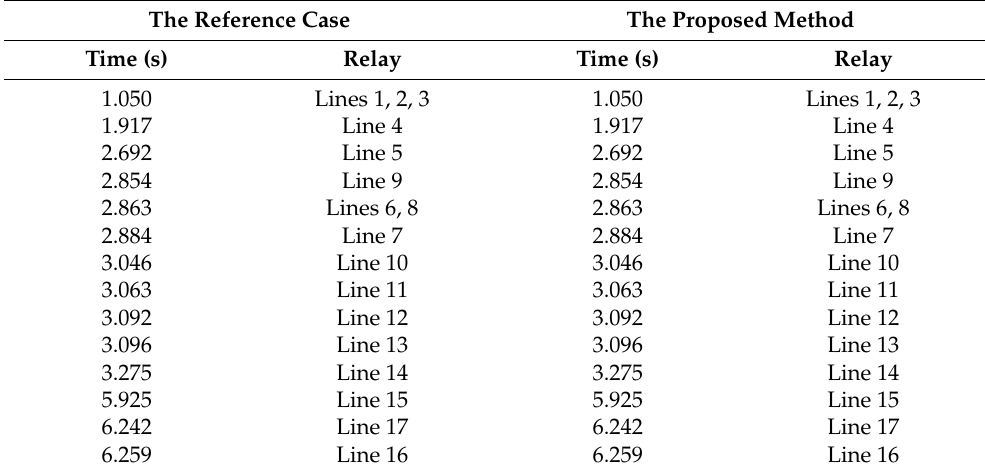
Table 6. The list of all distance relay operations in Contingency 2